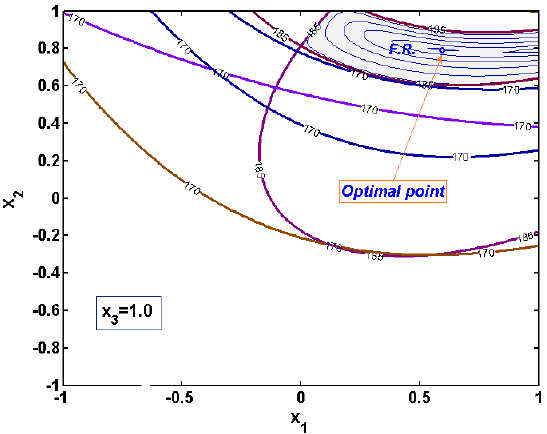
Figure 3. Overlaid contour plot for three design factors and six response constraints with x3: the heater block tempe– rature at optimal level (F.R. is the abbreviation for the feasible region)